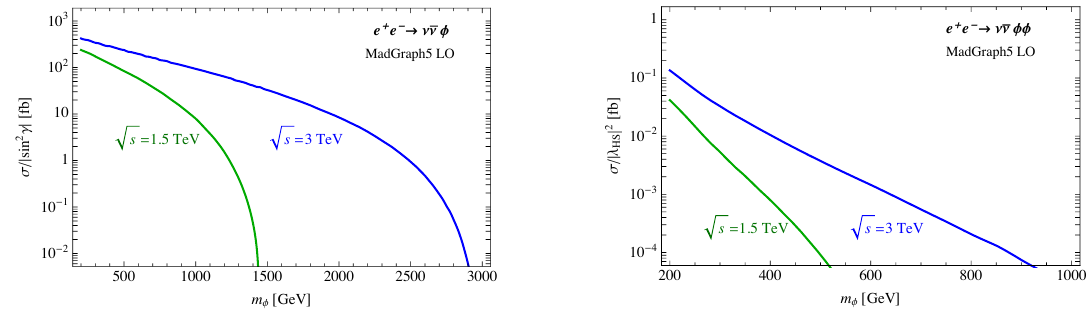
Figure 2. Left: single production via WW -fusion of a singlet. Right: pair production induced via WW -fusion of singlets, assuming sin 2 (cid:13) =